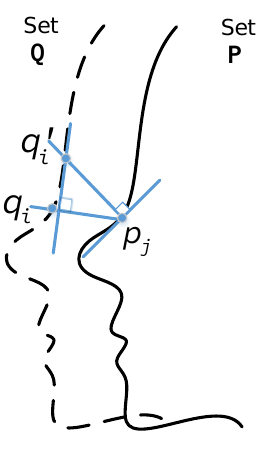
Figure 4. Point-to-Plane nearest neighbor search for point-cloud